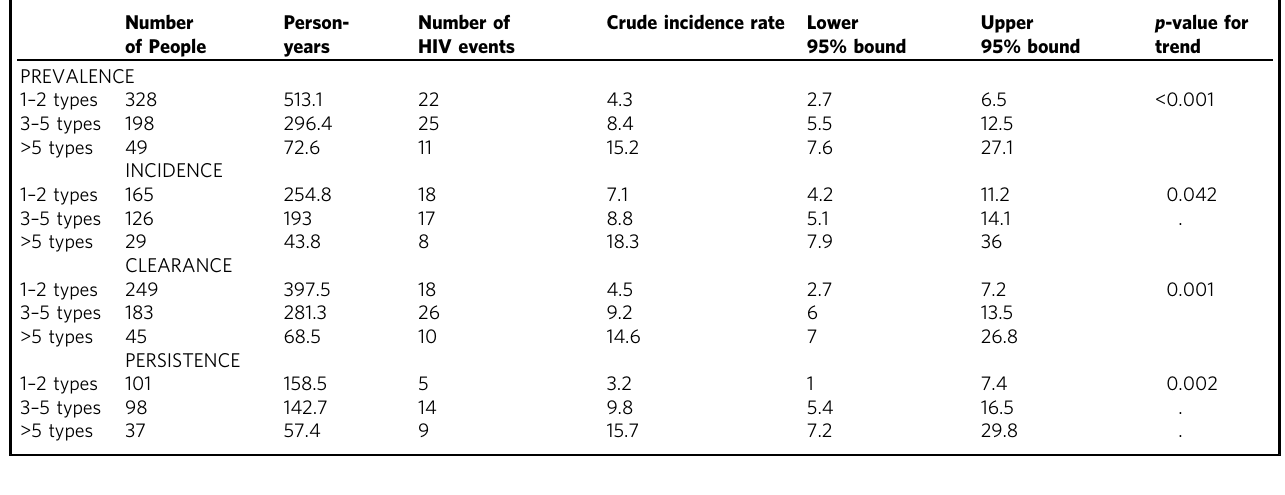
Table 3 HIV risk by the number of infecting HPV types Number of People